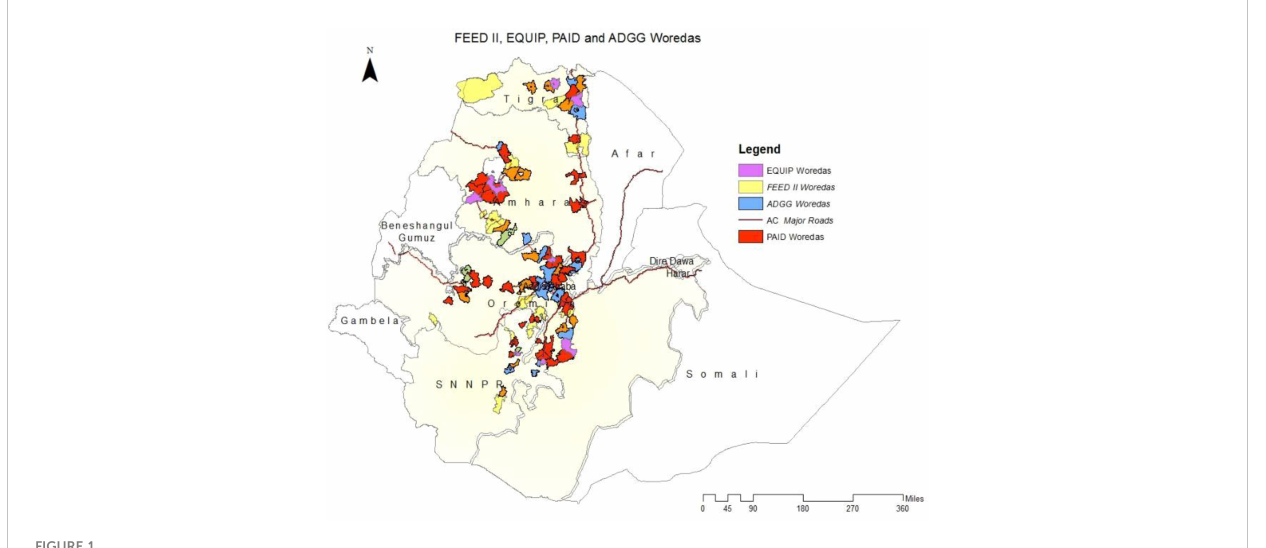
FIGURE 1 Study areas (the current study is represented by